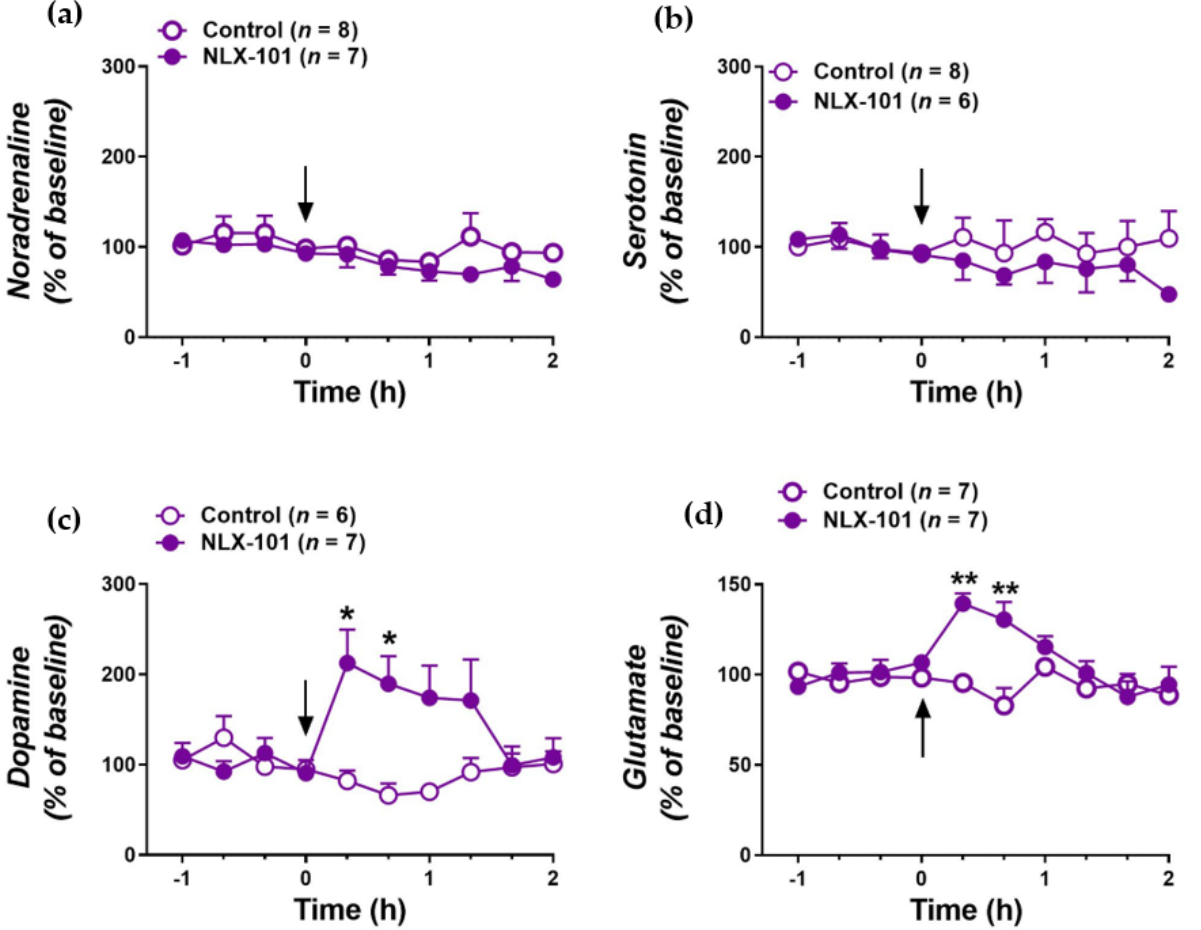
Figure 3. Effects of the administration of 0.16 mg/kg of NLX-101 or vehicle (arrow) on the extracellular concentration of noradrenaline ( a ), serotonin ( b ), dopamine ( c ) and glutamate ( d ) in the mPFC. Data (mean ± SEM) are expressed as percentage changes in the four basal pretreatment values. Number of animals is indicated in parentheses. * p < 0.05 and ** p < 0.0005 different from the corresponding vehicle group, Tukey’s multiple comparison test following significant two-way repeated measures ANOVA.